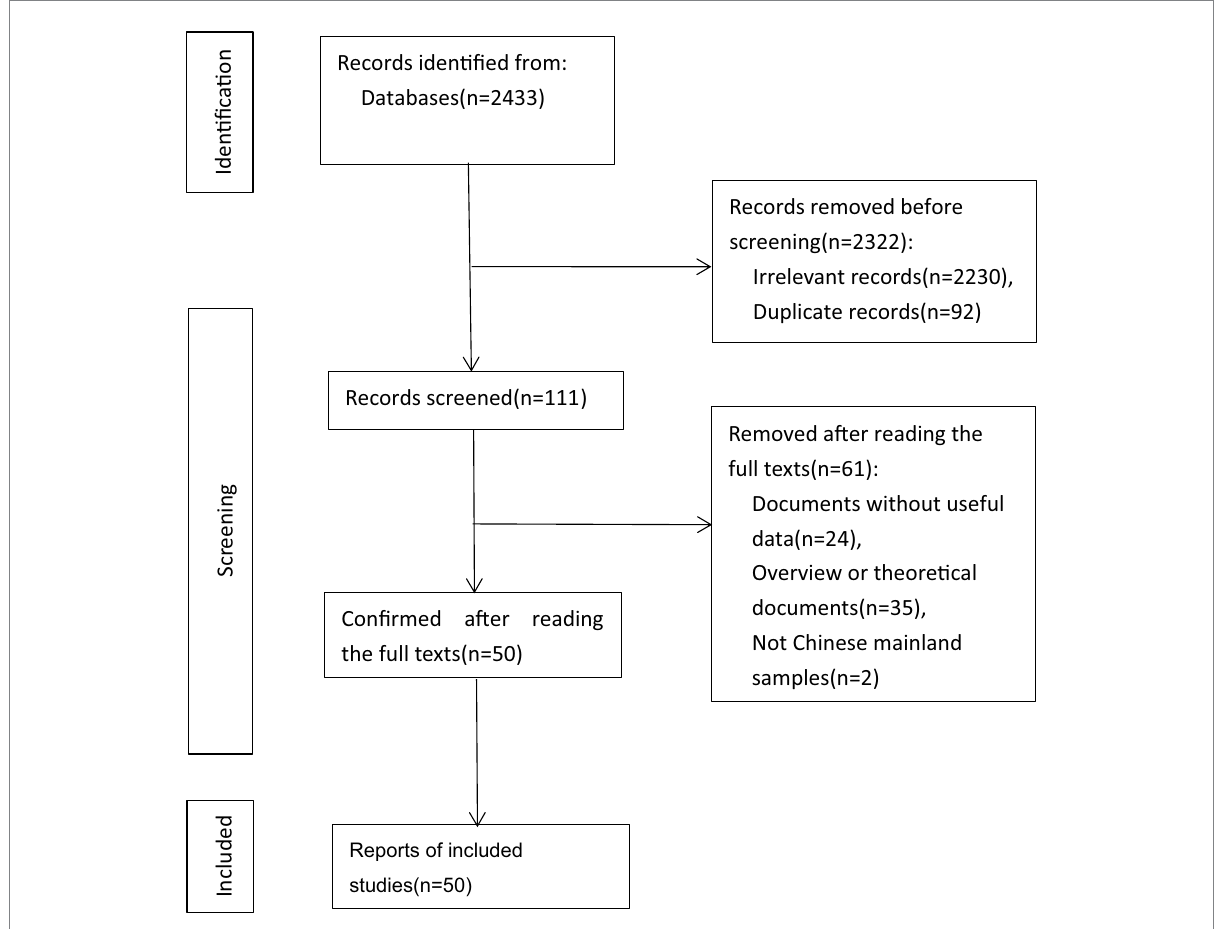
FIGURE 2 The PRISMA flow chart used to identify studies for detailed analysis of AB and